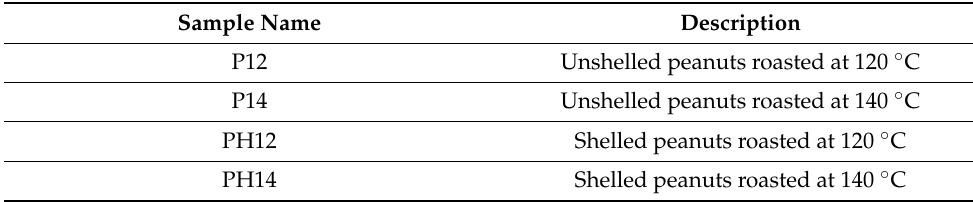
Table 5. The peanut oil sample preparation and its abbreviation.